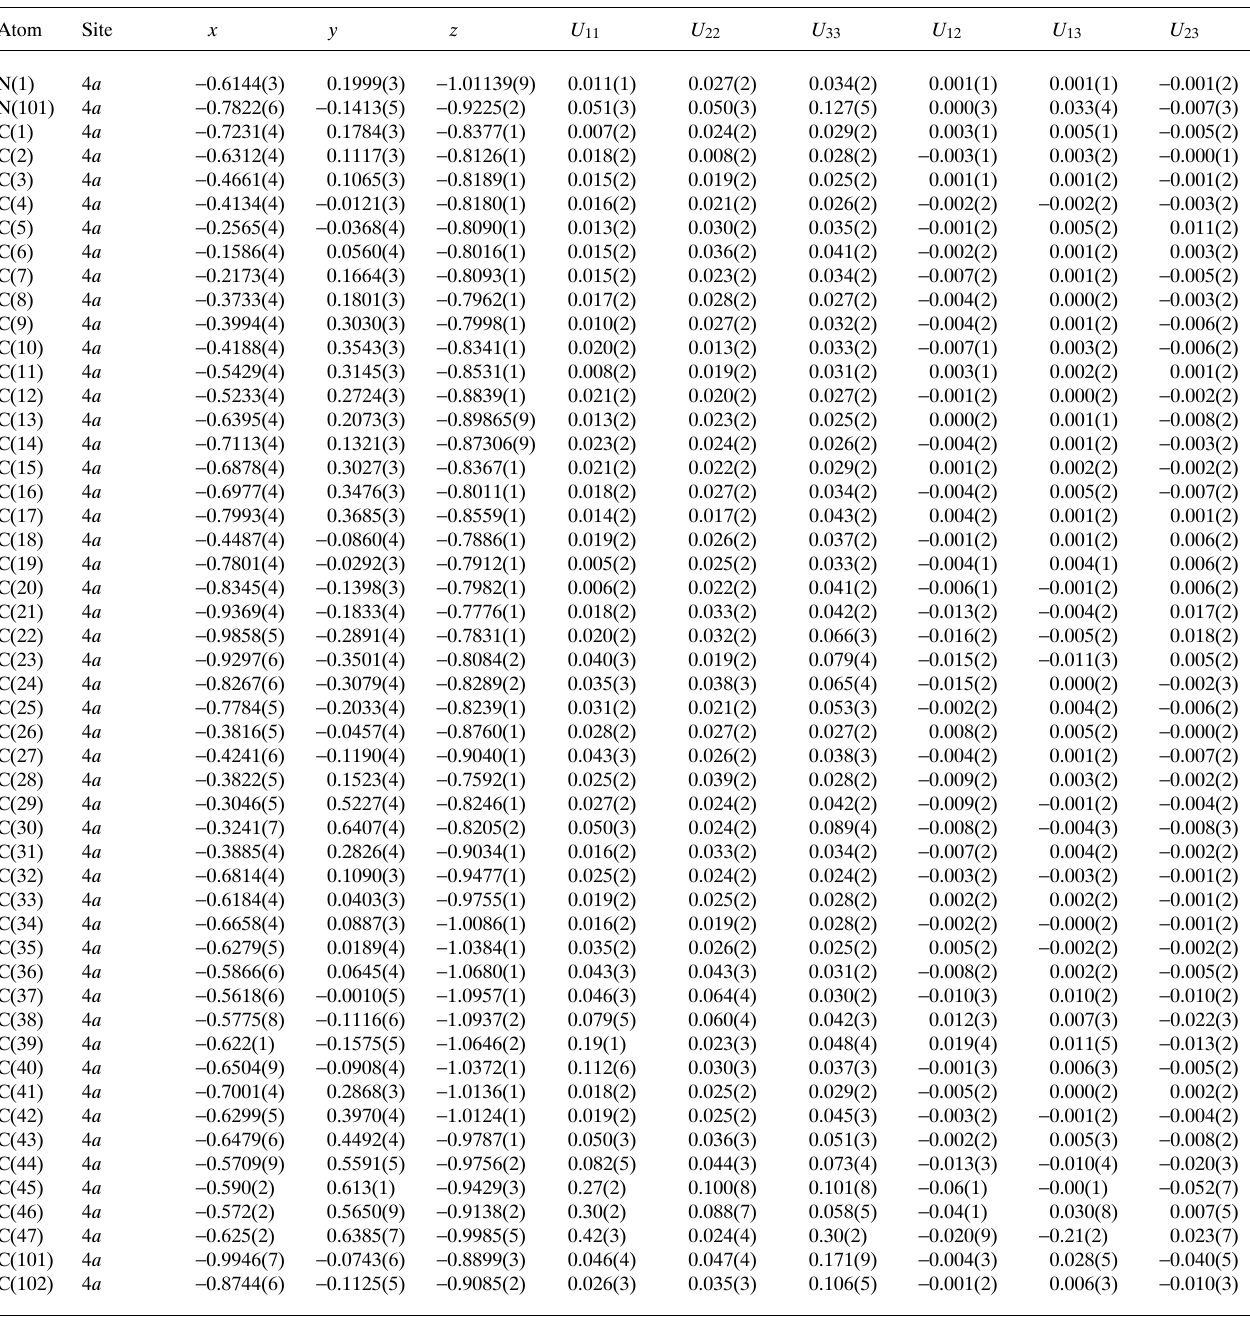
Table 3. C ontinued